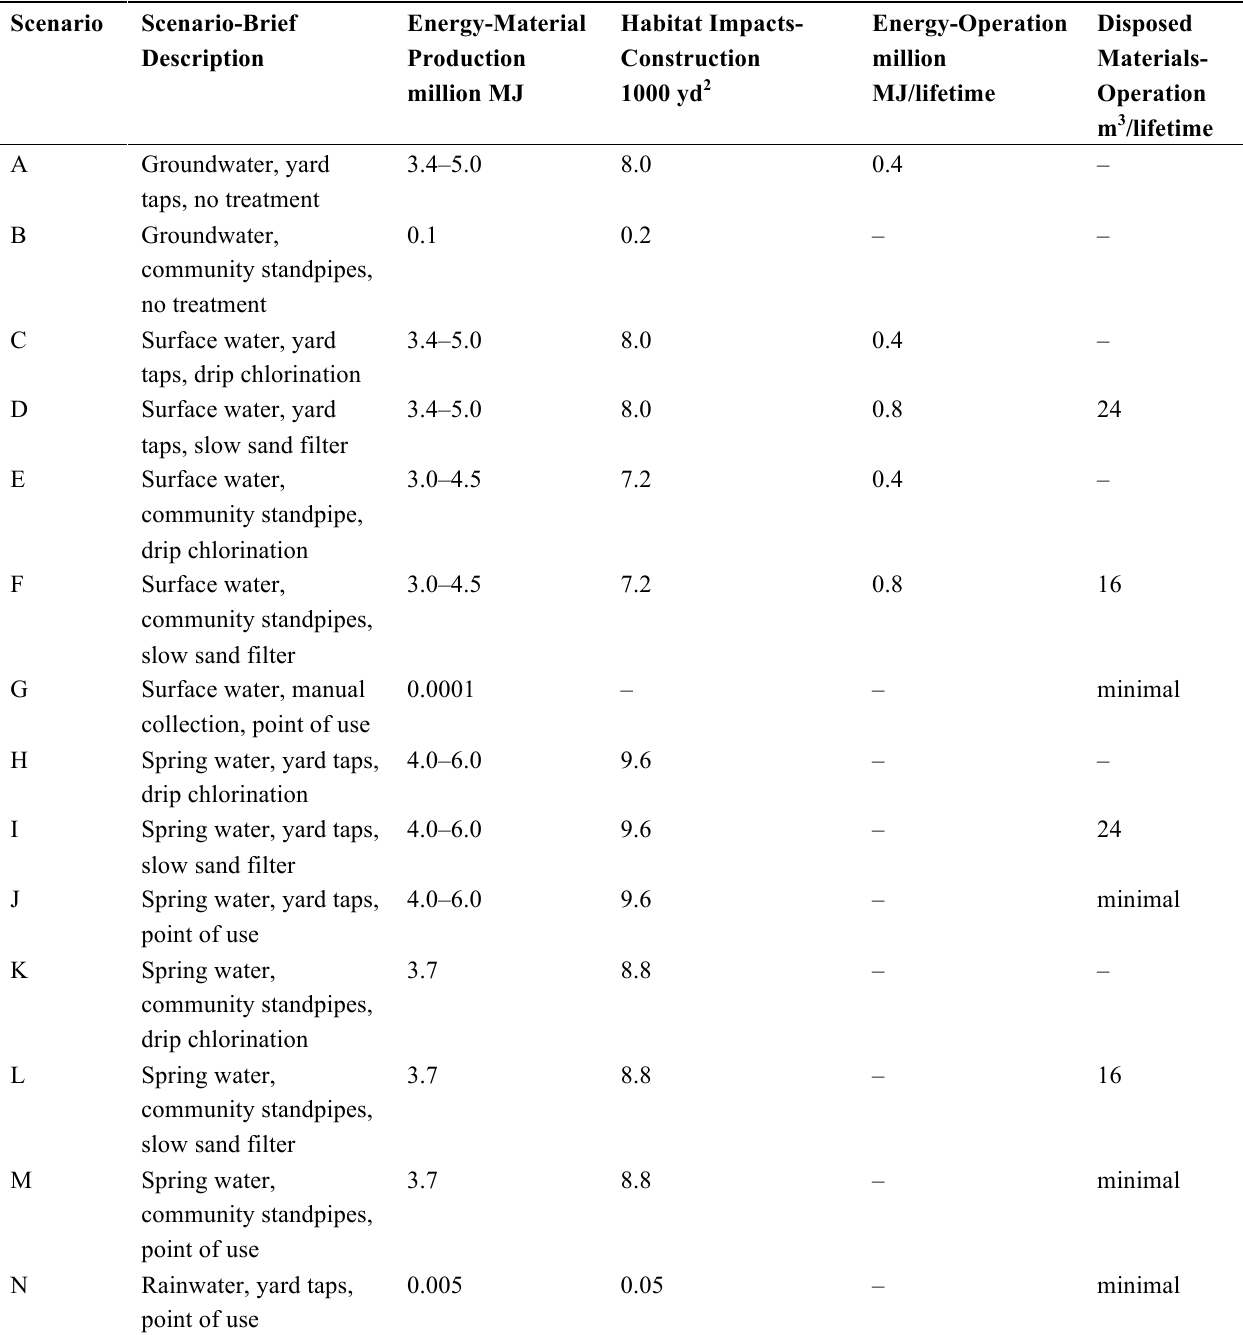
Table 8. Summary of life-cycle inventory for rural water